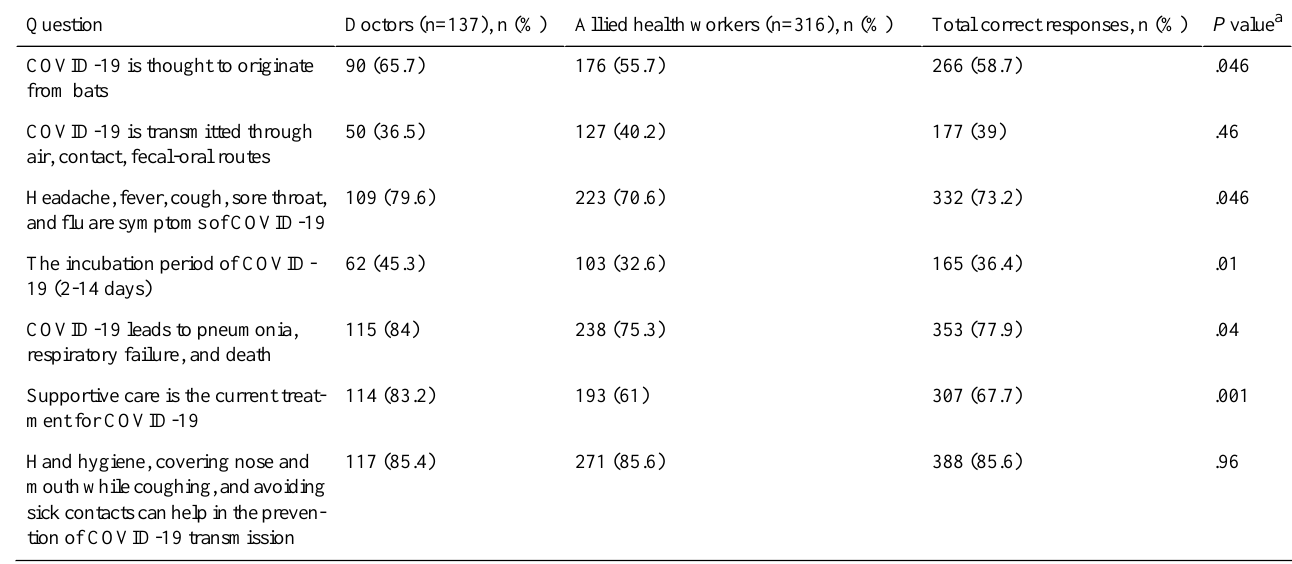
Table 3. Knowledge about coronavirus disease 2019 (COVID-19) among health care workers (N=453).